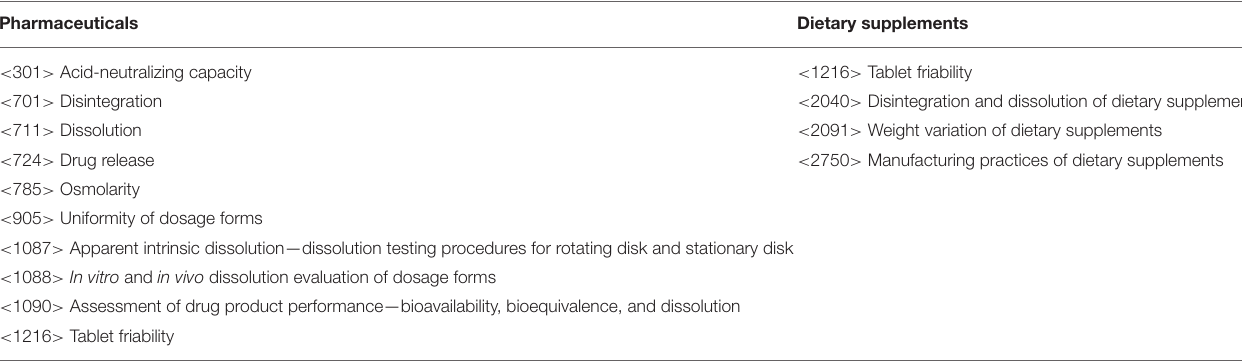
TABLE 1 | Pharmaceutical test scheme for pharmaceuticals and dietary supplements